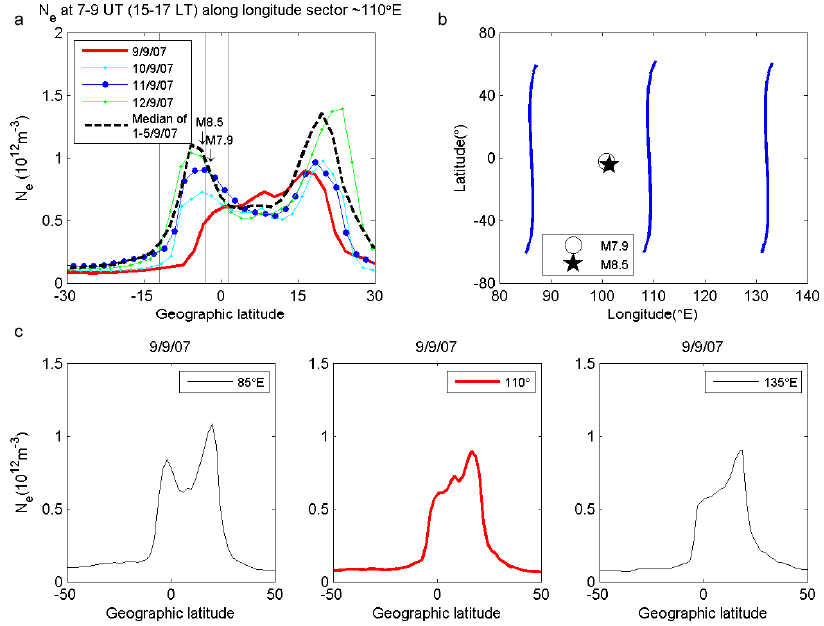
Fig. 11. The CHAMP N e variations observed from 07:00–09:00UT between 9 and 12 September 2007 and the median of 1–5 September. The latitude positions of COCO, BSAT and NTUS stations are also shown. (b) Satellite passes on 9 September and (c) N e measurements along the longitudes of 85 ◦ E, 110 ◦ E and 135 ◦ E.